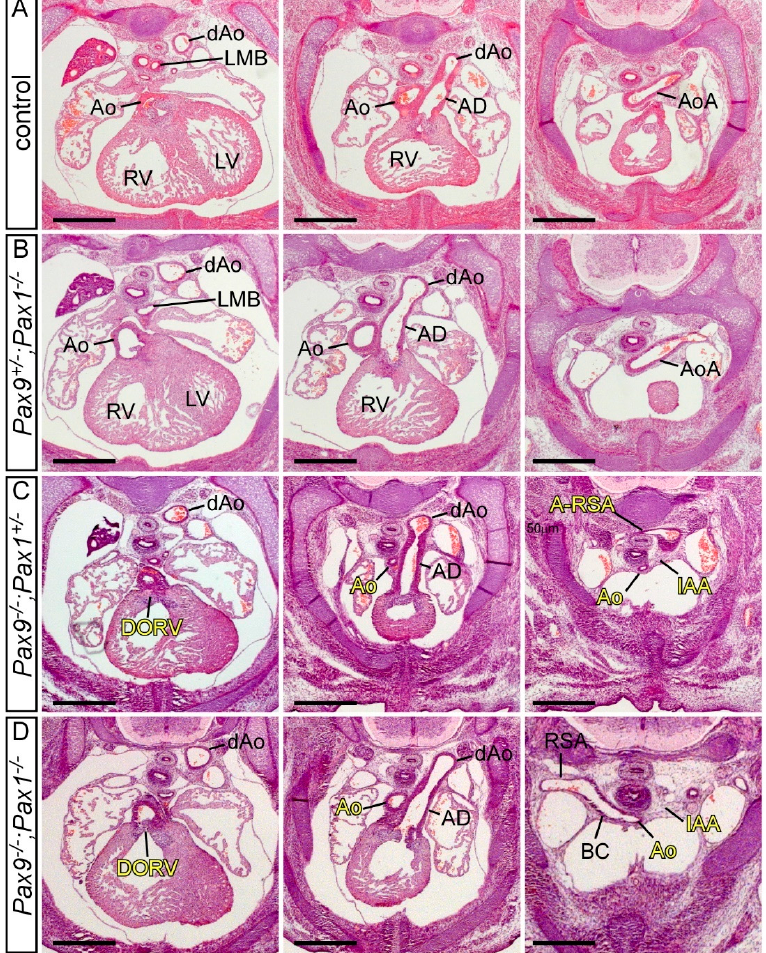
Figure 5. Pax1 and Pax9 do not genetically interact in cardiovascular development. Transverse hae- matoxylin and eosin-stained sections of E14.5 embryos. ( A ) Control embryo with normal outflow tract and arch artery morphology with the aorta arising from the left ventricle and the aortic arch crossing over the left main bronchus to join the dorsal aorta. ( B ) Embryo null for Pax1 heterozygous for Pax9 ( Pax9 +/– ; Pax1 –/– ) with normal cardiovascular development comparable to the control. ( C ) Embryo heterozygous for Pax1 and null for Pax9 ( Pax9 –/– ;Pax1 +/– ) displaying the typical cardiovas- cular defects seen in Pax9 -null embryos. The aorta arises aberrantly from the right ventricle produc- ing a double outlet right ventricle (DORV). The aorta is hypoplastic, with an interruption of the aortic arch (IAA) and an aberrant retro-oesophageal right subclavian artery (A-RSA). ( D ) Homozy- gous Pax9;Pax1 null embryo ( Pax9 –/– ;Pax1 –/– ) also with the typical Pax9-null cardiovascular defects, except with a normal right subclavian artery. Abbreviations: Ao, aorta; AoA, aortic arch; AD, arterial duct; BC, brachiocephalic artery; dAo, dorsal aorta; LMB, left main bronchus; LV, left ventricle; RSA, right subclavian artery; RV, right ventricle. Scale bar: 500 µm. 4. Concluding Remarks Despite the Pax family consisting of nine genes all involved in embryonic develop- ment, only Pax3 and Pax9 play major roles in cardiovascular development involving NCC deficiencies, but through expression in different tissues. Pax3 acts cell autonomously in the NCC and is crucial for their migration and the subsequent septation of the outflow